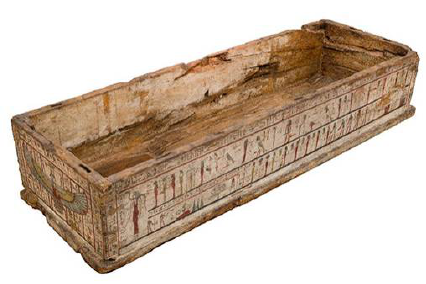
Figure 4. The wooden sarcophagus depicted.